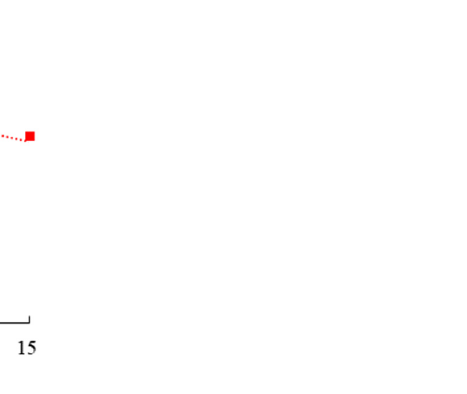
Table 7. The specific energy of driving force at different microwave exposure times. Table 7. The speci fi c energy of driving force at di ff erent microwave exposure times.